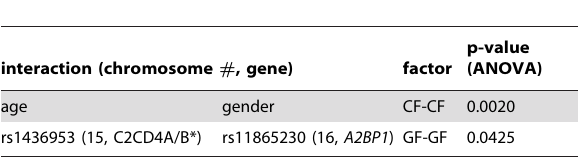
Table 2. A list of significant interaction